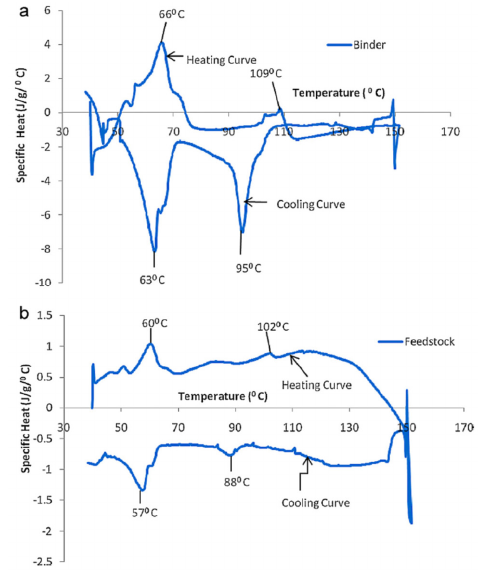
Figure 1. Specific heat of ( a ) binder and ( b ) feedstock during heating and cooling cycles derived from DSC results. Reprinted from [19] with permission from Elsevier.